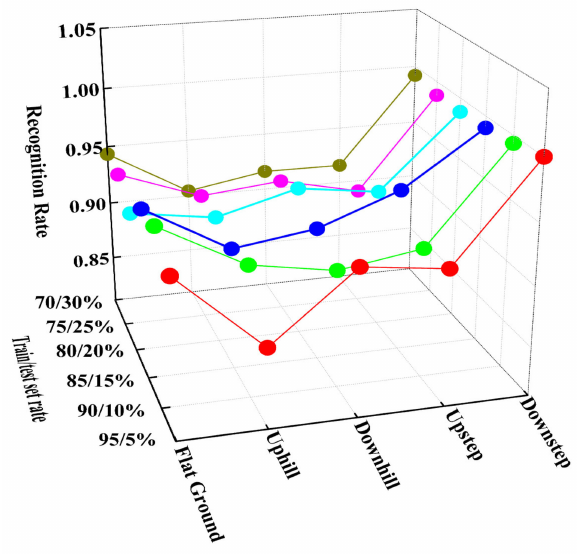
Figure 13. The recognition rate of the lower limb EMG signal according to gait.